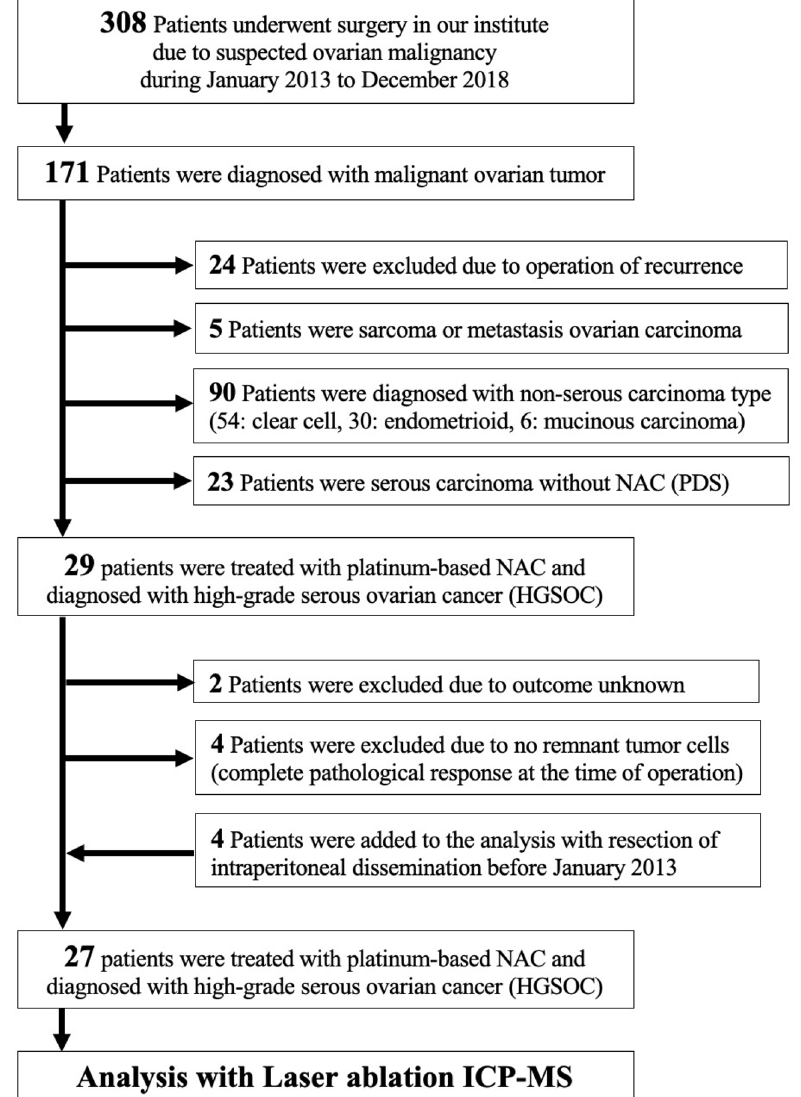
Figure 3. Flowchart of patient inclusion. We enrolled the total of 308 patients who were suspected of having ovarian malignancy and underwent surgery at our institution during the period from January 2013 to December 2018. Among of them, 171 patients were diagnosed with malignant ovarian cancer. The 27 patients with HGSOC at stage III or IV according to the revised 2014 FIGO staging system who were treated with NAC-IDS including platinum-based agents were analyzed in this